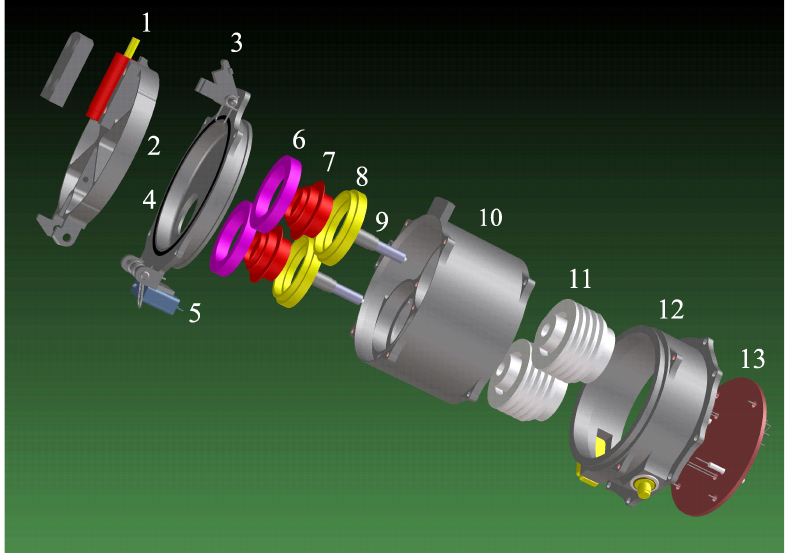
Fig. 3. Enhanced view of an emitter module. 1: pyrotechnic piston actuator, 2: protective cover, 3: clamp, 4: top ring with outer electrode, 5: microswitch, 6: isolator, 7: extractor electrode, 8: isolator, 9: ion emitter, 10: main housing, 11: thermal isolation, 12: electronics housing, 13: printed circuit board.